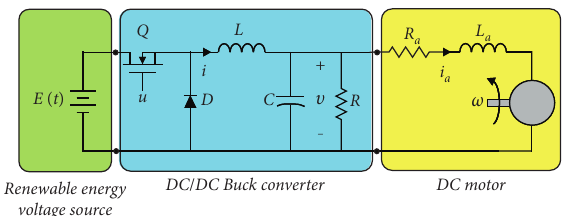
Figure 1: DC/DC Buck converter-DC motor